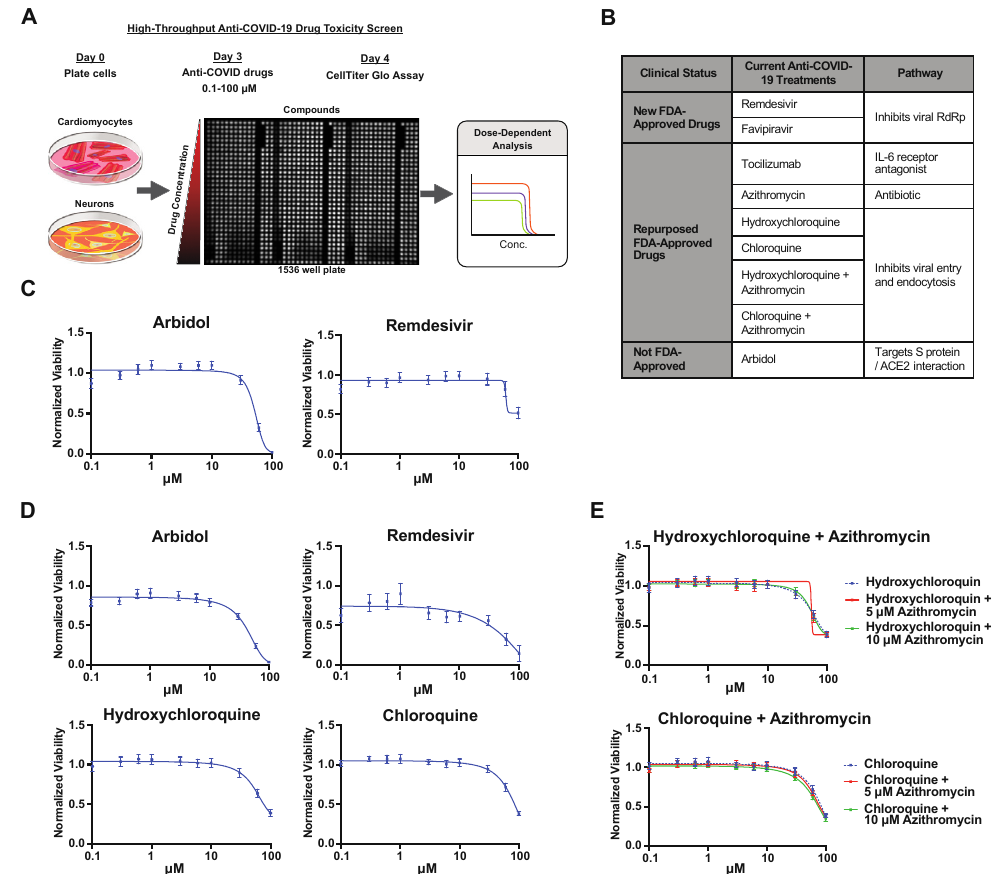
Figure 2. Identification of cardio– and neurotoxic compounds used for the treatment of SARS-CoV-2 infection: ( A ) Workflow of cardio– and neurotoxicity screen using potential anti-COVID-19 compounds with an example image of a 1536-well plate following CellTiter-Glo assay; ( B ) table of selected anti-COVID-19 compounds; ( C – E ) comparative evaluation of cell viability by CellTiter–Glo assay following 24-h exposure to COVID-19 treatments in ( C ) hiPSC-CMs and ( D ) hiPSC–NEURs (n = 3). ( E ) Comparative evaluation of cell viability by CellTiter-Glo assay following 24-h exposure to COVID-19 treatments in neurons. All data represent mean ± SEM from the 13 cell